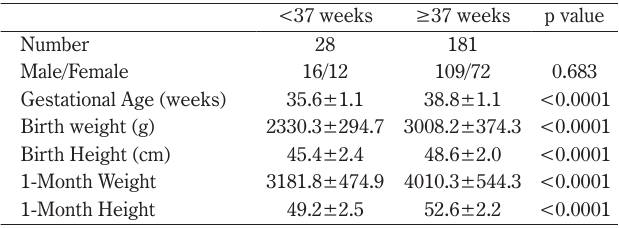
Figure 1 Measurement of RR interval (RR) and QT intervals. Electrocardiograms (ECGs) were recorded by the CM5 lead using a Biopac biological polygraph recording device (Goleta, CA). Q onset, T end, and preceding RR intervals were measured using first derivative processing (B) and absolute functions (C) from 60 consecutive beats with a stable baseline ECG. Table 1 Characteristics of subjects for the total sample stratified by gestational